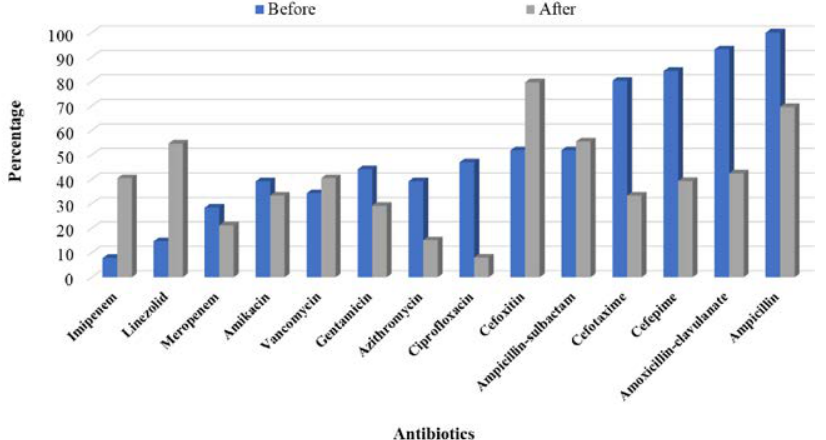
Fig. 3. Resistance pattern of the isolated Gram-positive cocci before and after the intervention